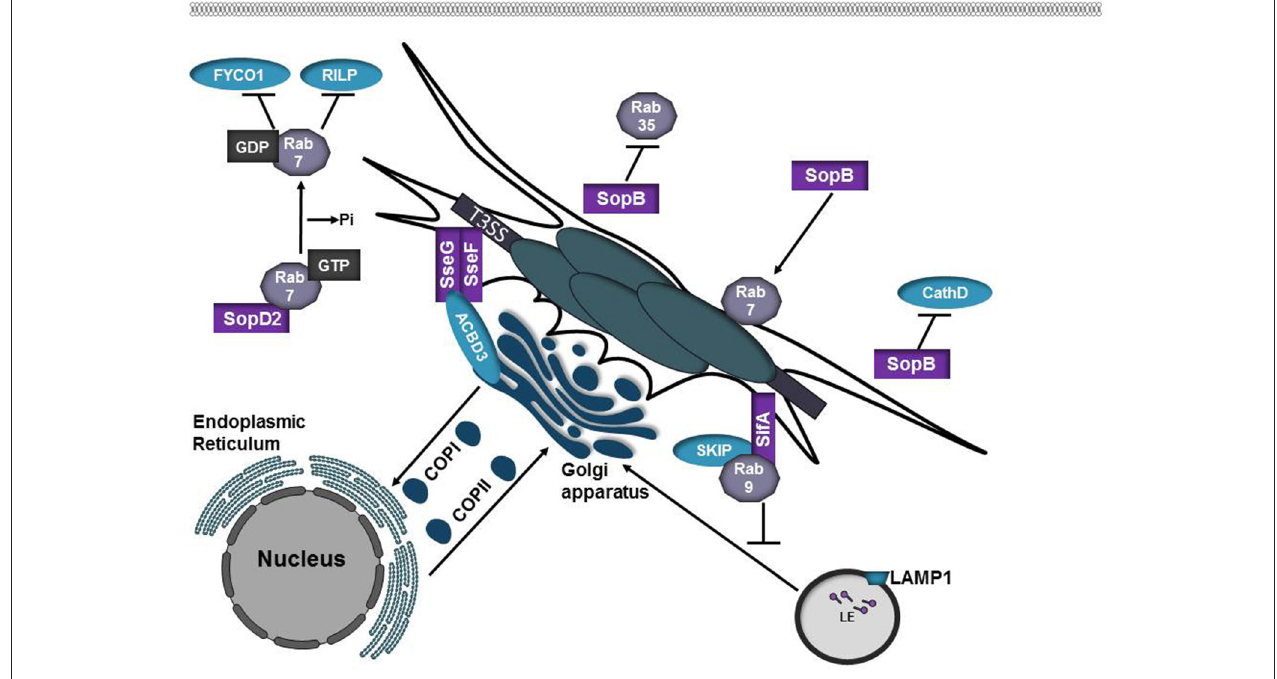
FIGURE 4 | Salmonella SPI-2 effector proteins participate in SCV formation. SopB is phosphoinositide phosphatase that alters the membrane surface charge of the SCV. This prevents targeting by Rab35 while promoting recruitment of Rab7. SopB also inhibits targeting of the lysosomal protease Cathepsin D to the SCV. SopD2 is a Rab7 GAP. Inactivation of Rab7 by SopD2 prevents interactions with the Rab7 effectors RILP and FYCO1. SifA is inserted into the SCV membrane where it interacts with SKIP/PLEKHM2. SifA-SKIP sequesters Rab9 at the SCV, inhibiting retrograde trafficking of mannose-phosphate receptors (MPRs) to the trans- Golgi network. SseF and SseG are integral membrane effector proteins that form a trimolecular complex with ACBD3 to anchor the SCV to the Golgi apparatus.